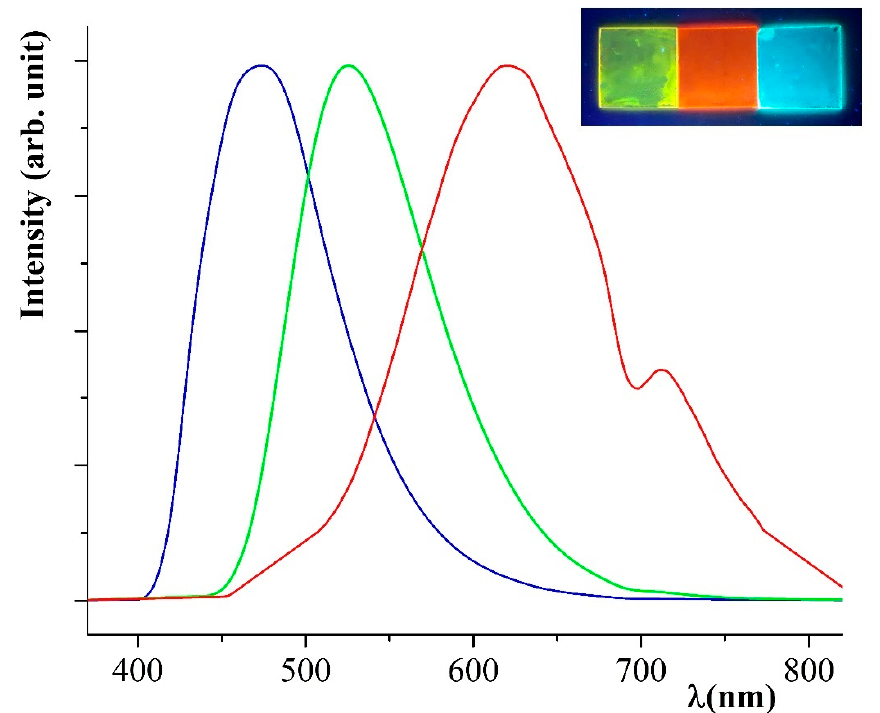
Figure 2. Normalized emission curves recorded on thin film (blue curve) samples of P B (blue curve), P G (green curve) and P R (red curve). In the inset: The same spin-coated thin films (respectively P G , P R and P B from left to right) photographed under the UV lamp at 365 nm.